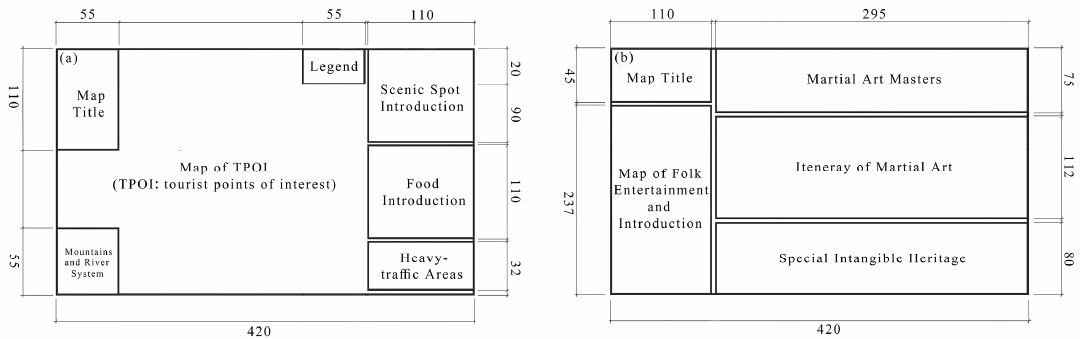
Figure 8. The layout design and expression objects of the tourist map of Foshan: ( a ) front of the map; ( b ) back of the map.